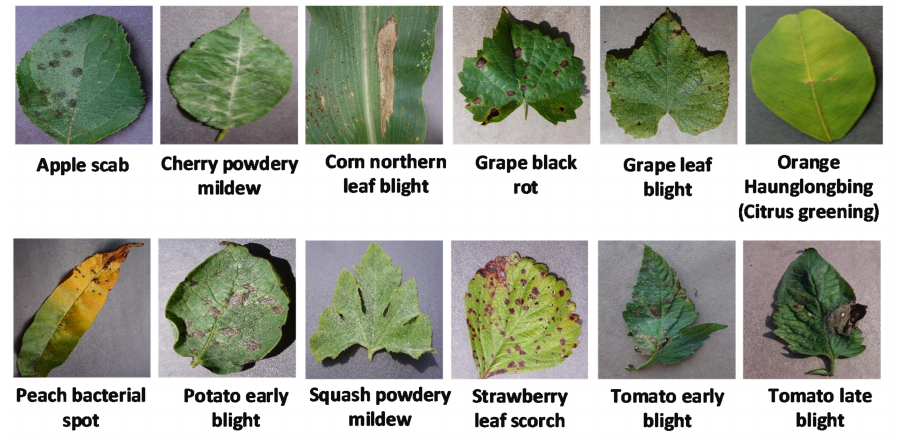
Figure 3. Some of the plant diseases from the PlantVillage dataset